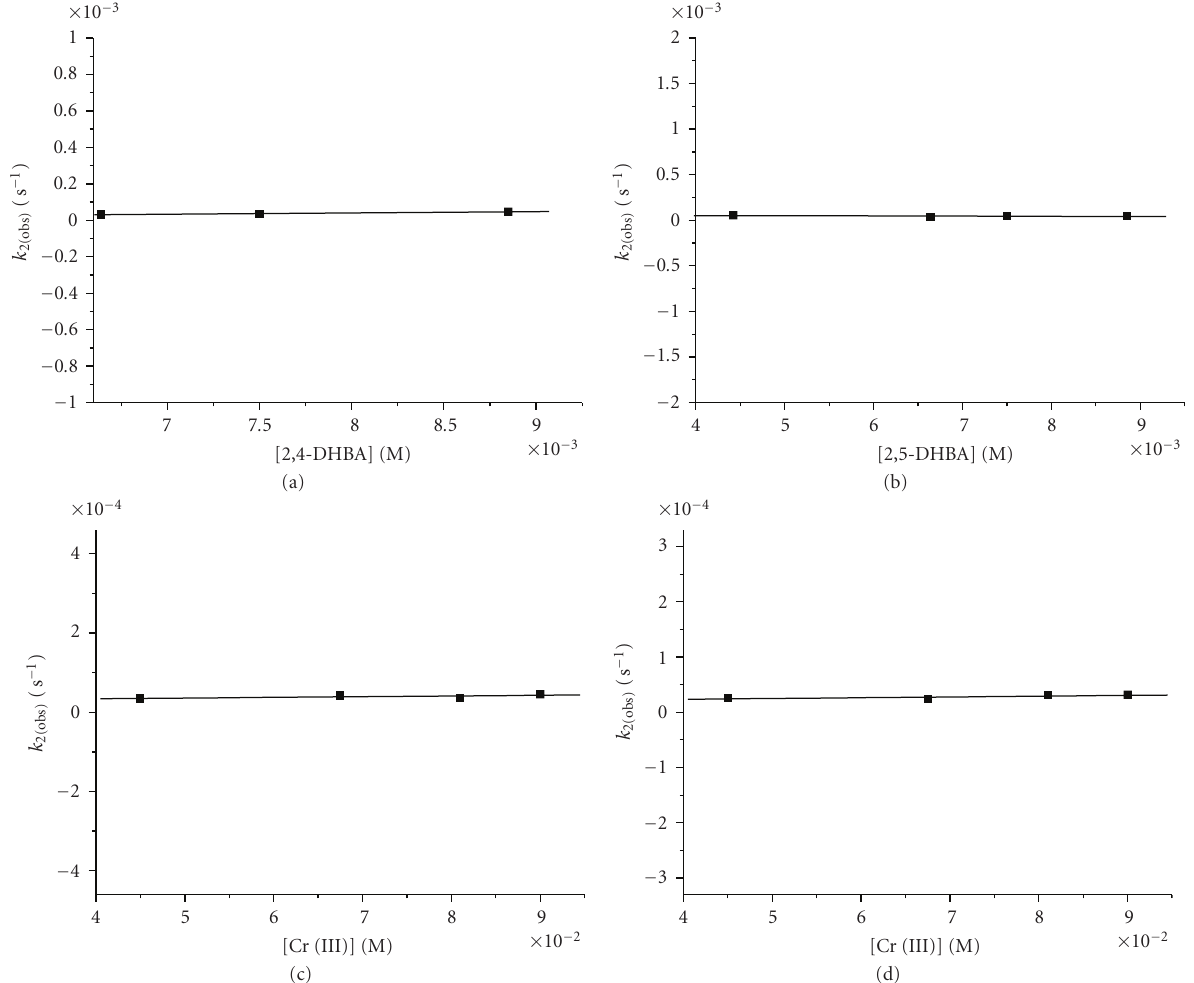
Figure 7: Ligand and Cr(III) concentration dependence of k 2(obs) . Conditions: (a) [2,4-DHBA] = (6.64–8.85) 10 − 3 M, [Cr(III)] = 1.25 10 − 3 M, T = 313 K, (b) [2,5-DHBA] = (4,42–8.85) 10 − 3 M, [Cr(III)] = 1.25 10 − 3 M, T = 313 K, (c) [2,4-DHBA] = 8.8510 − 3 M, [Cr(III)] = (4.5–9.00) 10 − 2 M, T = 313 K, (d) [2,5-DHBA] = 8.85 10 − 3 M, [Cr(III)] = (4.5–9.0) 10 − 2 M, T = 308